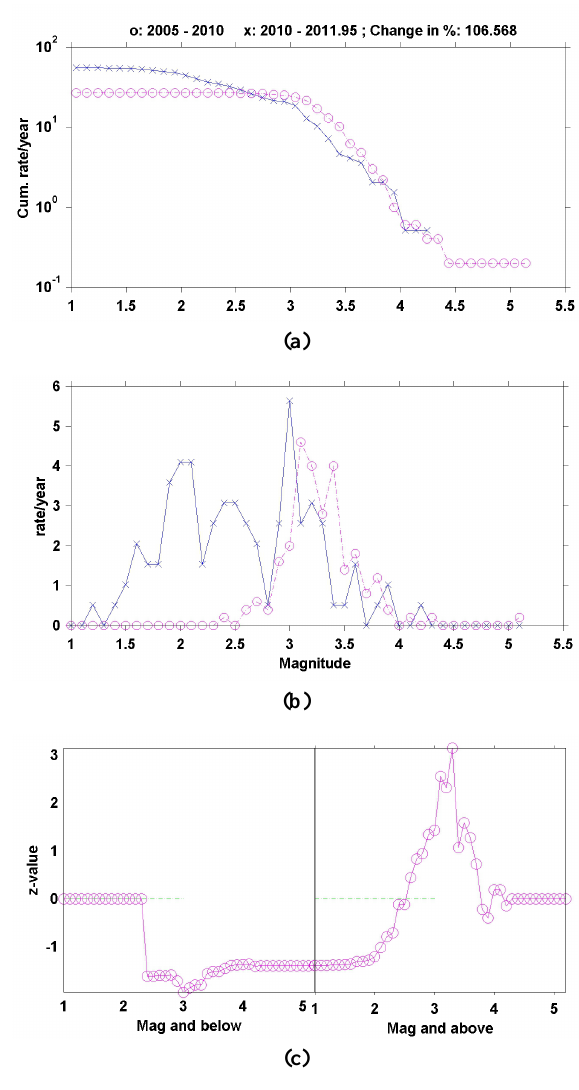
Fig. 4. Comparison of the rates as a function of magnitude for the two periods, which are printed at the top. The numbers are normal- ized by the duration of the periods. (a) Frequency-magnitude curve. (b) Non-cumulative numbers of events as a function of magnitude. (c) Magnitude